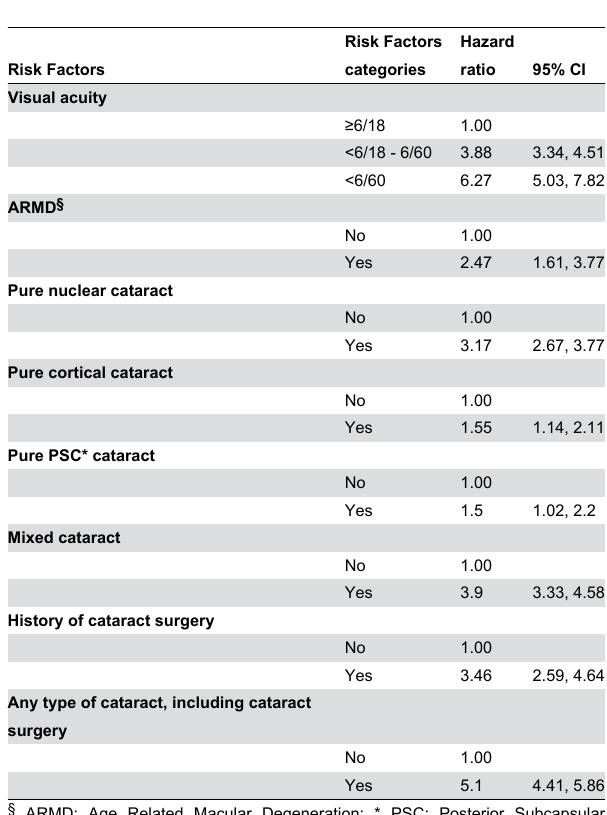
Table 3. Univariable association of systemic disease, demographic and lifestyle factors with mortality.